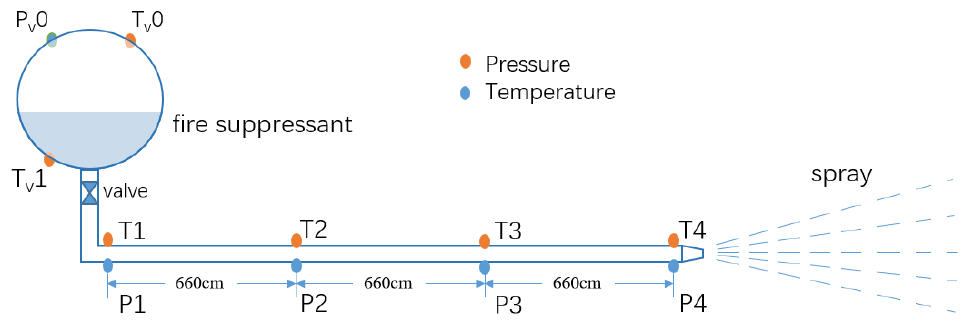
Figure 1. Schematic illustration of the experimental